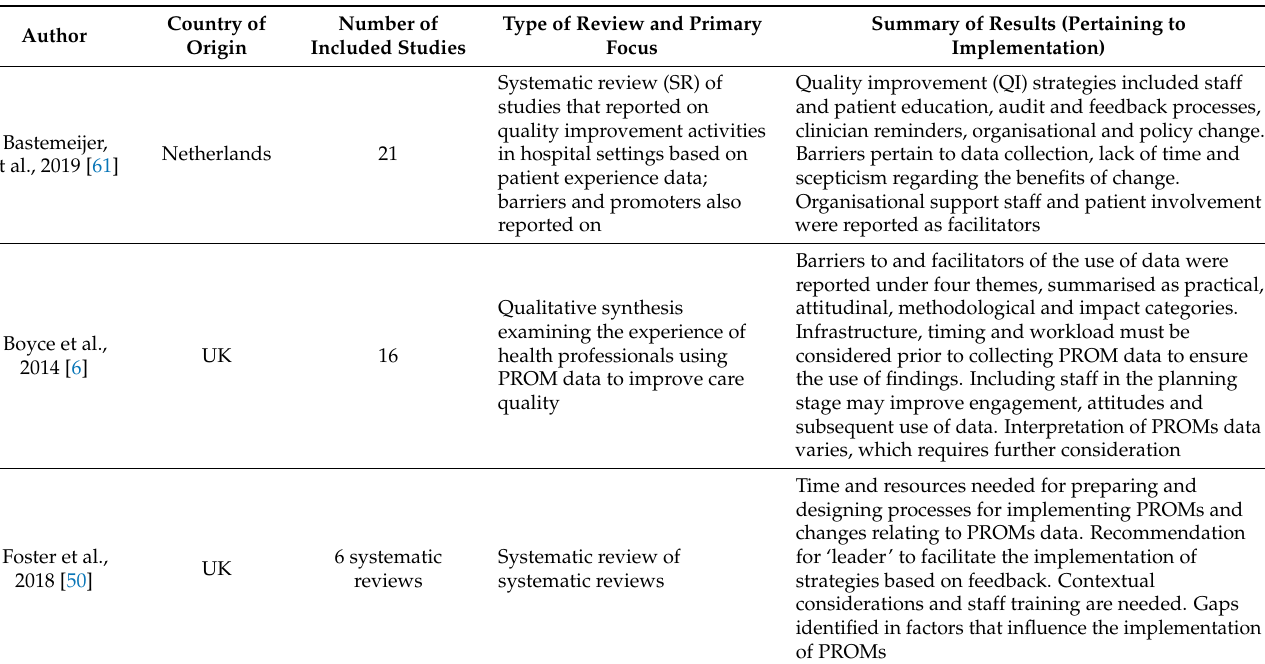
Table 1. Characteristics of systematic reviews relevant to the